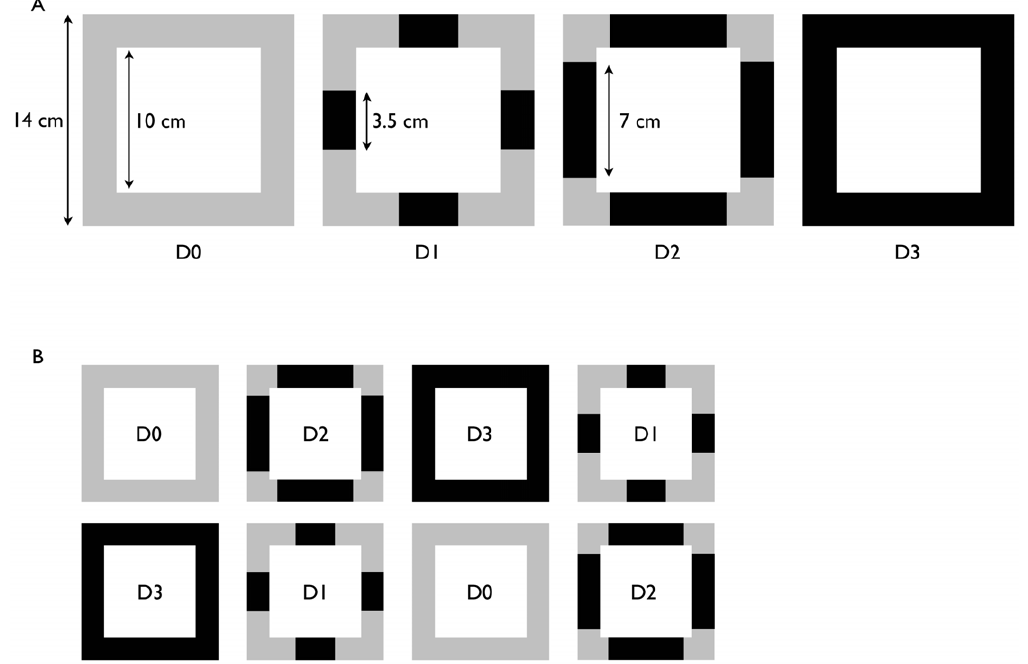
Figure 1. Diagram illustrating the experimental design employed. (A) We applied 4 different loads of a copper based antifouling paint: no disturbance (D0), 28 cm 2 of AF paint (D1), 56 cm 2 of AF paint (D2) and 96 cm 2 of AF paint (D3). (B) Representation of one block with 2 replicates per treatment.